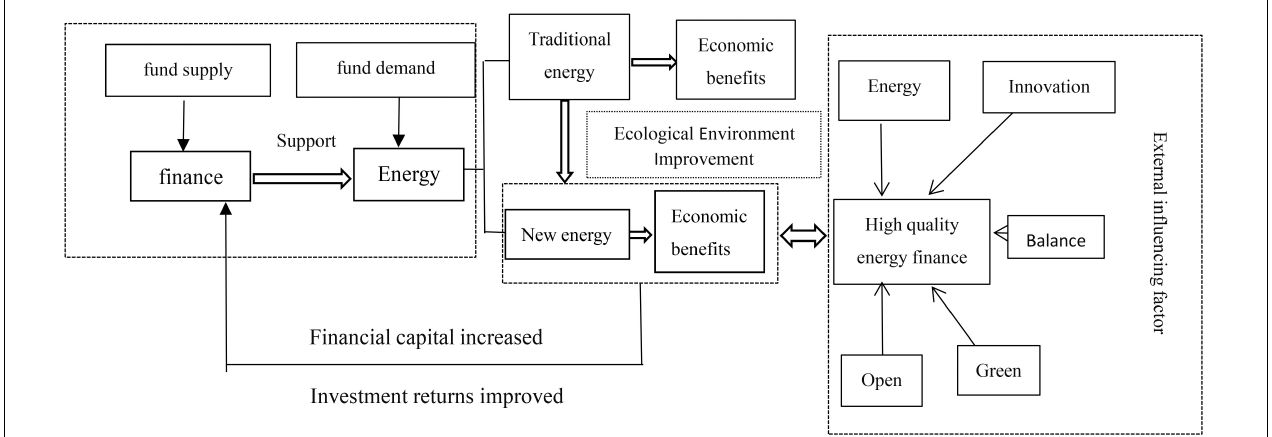
FIGURE 1 | Schematic diagram of high-quality activities in energy